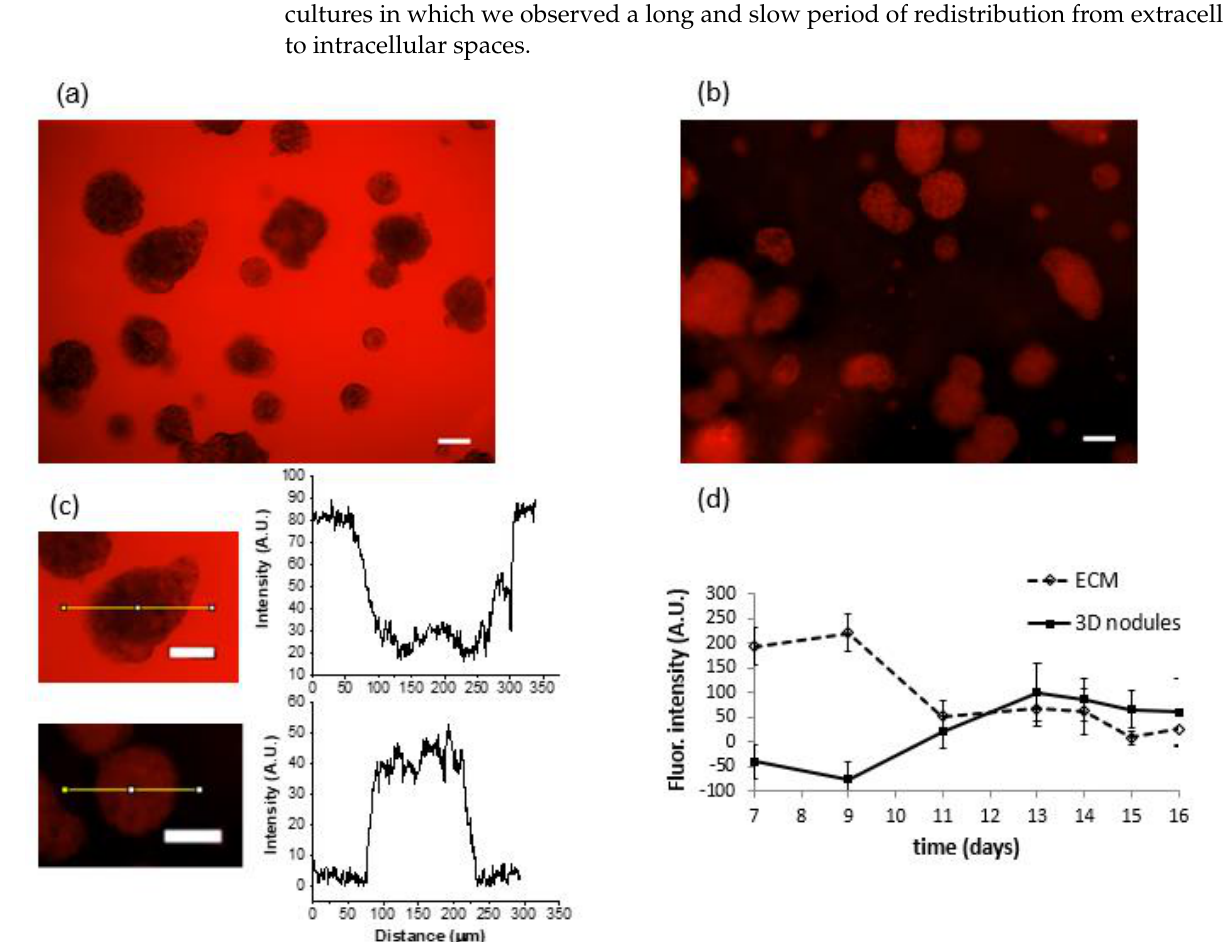
Figure 3. Longitudinal monitoring of fluorescence intensity from fluorophore-labeled GNPs: ( a ) after 45 min of cancer nodule exposure to GNPs, Matrigel appeared red due to GNP localization within the ECM. Due to a strong interaction of Matrigel and GNPs, particles were incapable of migrating immediately to cancer nodules and are retained in the matrix. Scale bar is equal to 100 µm; ( b ) a 3D nodule of A549 lung cancer at day 13, which was 6 days after exposure to GNPs. Most of the GNPs moved from the Matrigel to cancer nodules, which turned red due to fluorophore presence, while Matrigel appeared black. Scale bar is equal to 100 µm; ( c ) the intensity drop between Matrigel and a nodule at day 1, as well as the intensity jump at day 6, are also confirmed using ImageJ software. Scale bar is equal to 100 µm; ( d ) fluorophore intensity in the ECM (dashed line) and in the nodules (solid line) with standard error (SE), n = 3. Light emitted by fluorophore accumulation in Matrigel decreased over time unlike light intensity emitted by fluorophore in cancer cells. Light intensity emitted by tumor nodules constantly increased and reached the maximum at day 13, which was 6 days after the addition of GNPs. In order to obtain the appropriate intensity, a control group was used to determine the background, which was subtracted from each individual image.